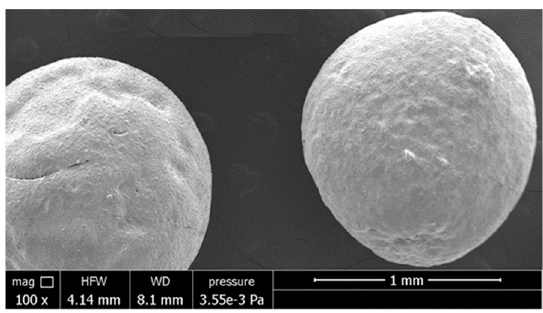
Figure 7. SEM images of Li 4 SiO 4 pebbles obtained by drip casting process.